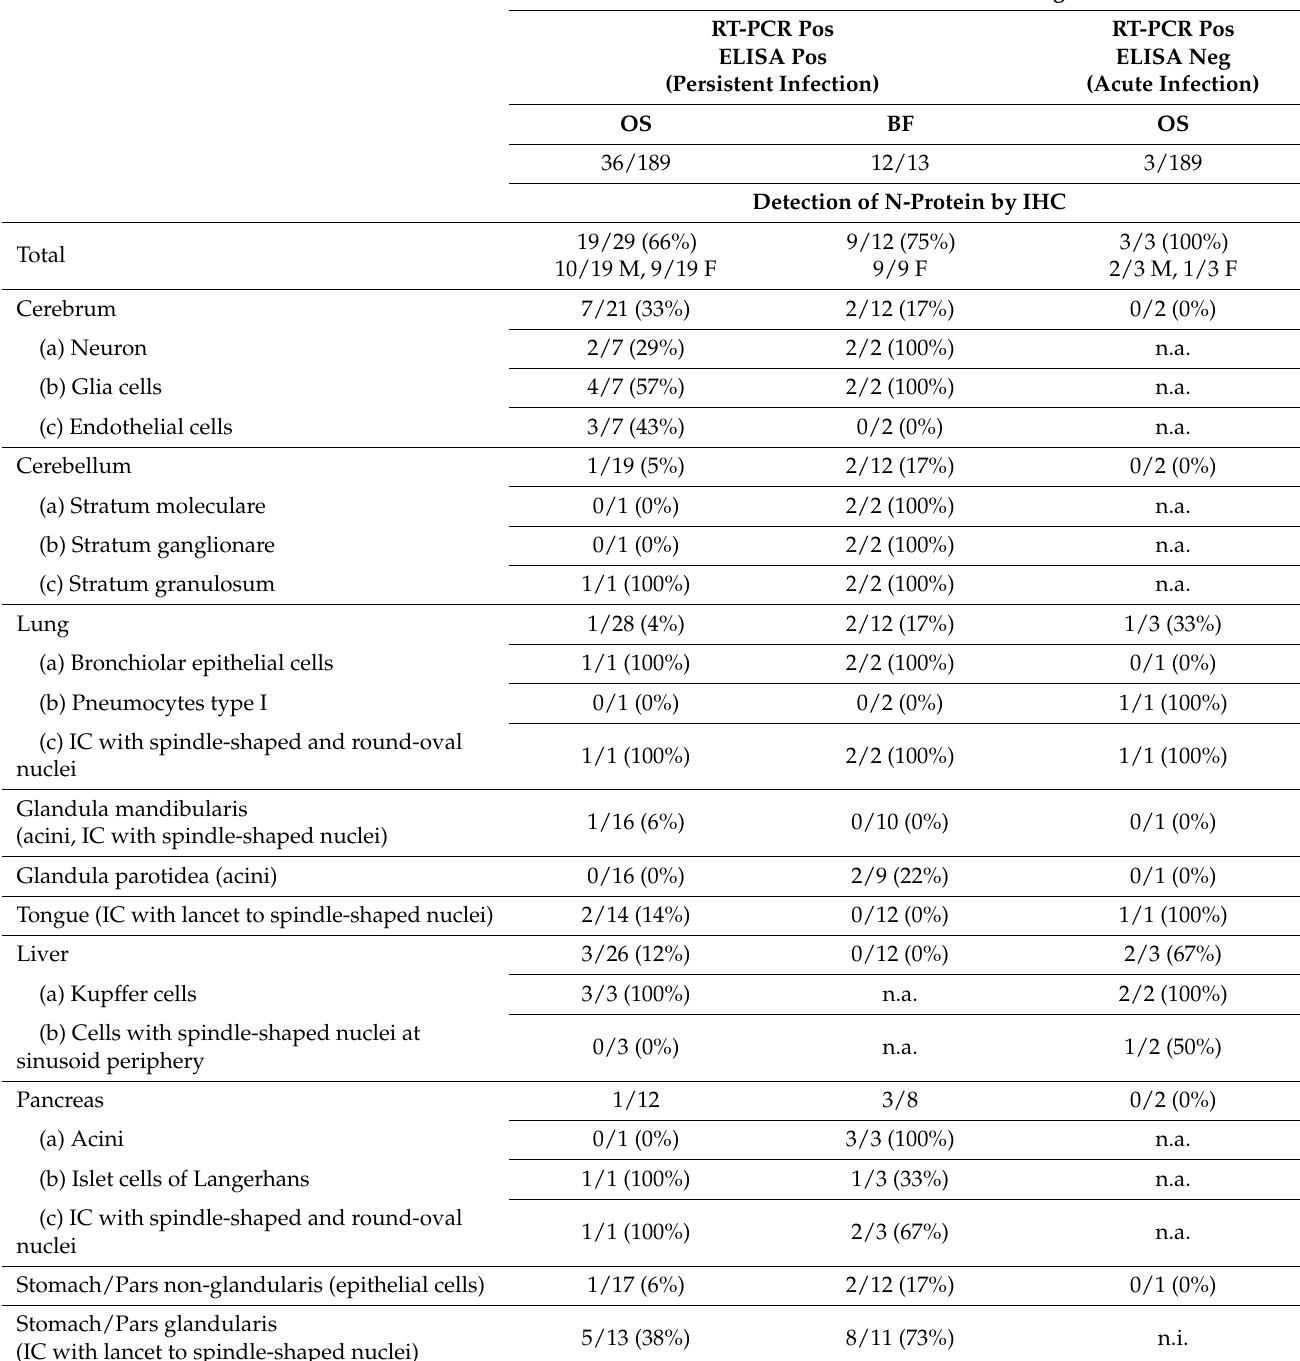
Table 1. Detection of Puumala orthohantavirus (PUUV) RNA by RT-PCR, anti-PUUV IgG antibodies by ELISA and immunohistochemistry (IHC)-based detection of nucleocapsid (N)-protein in bank voles from the district Osnabrück (OS) and the breeding facility